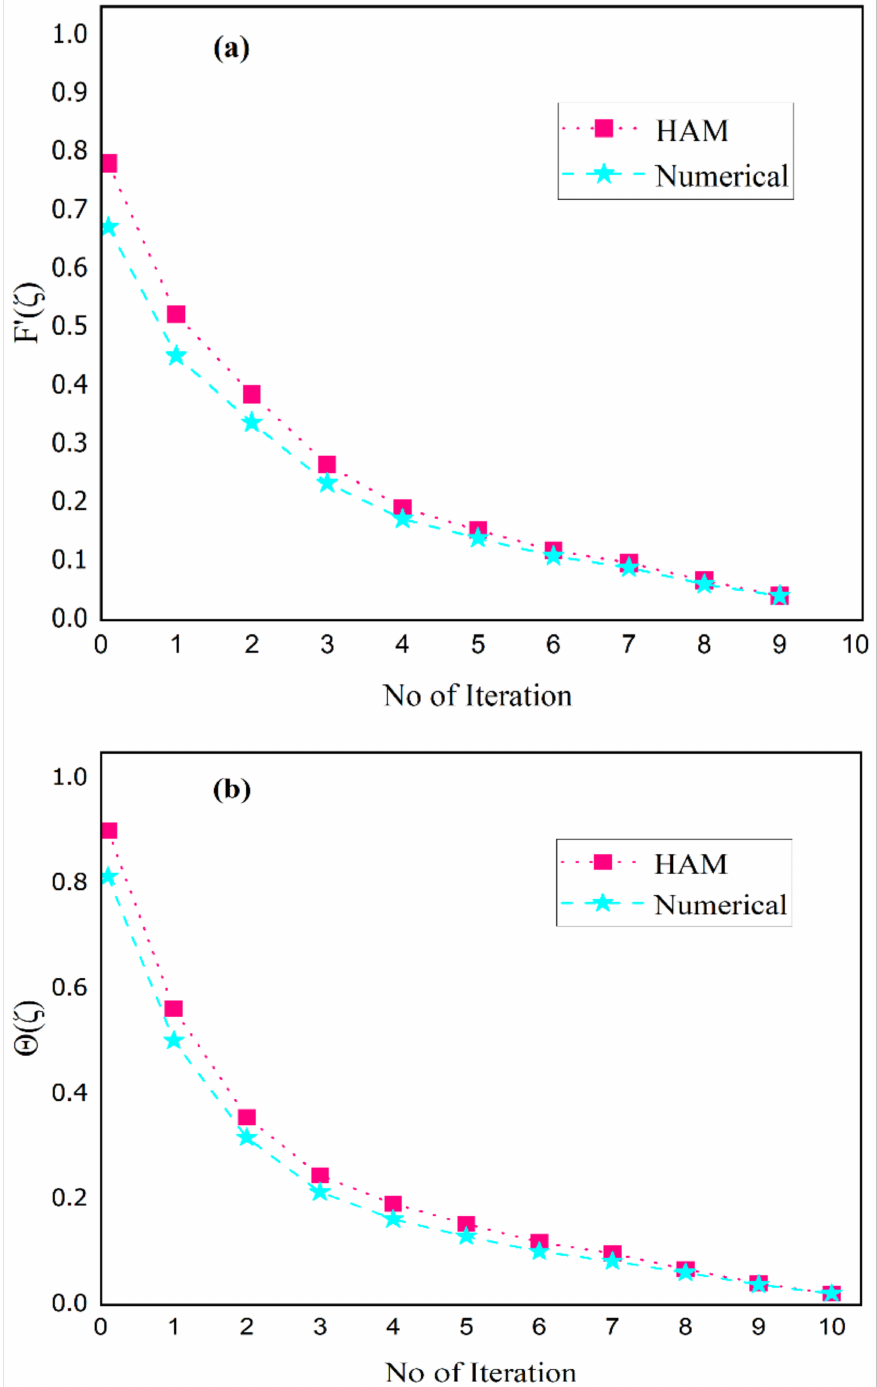
Figure 13. Comparison of HAM and numerical solution subject to ( a ) f (cid:48) ( η ) and ( b ) Θ ( η ) by taking φ = 0 (H 2 O